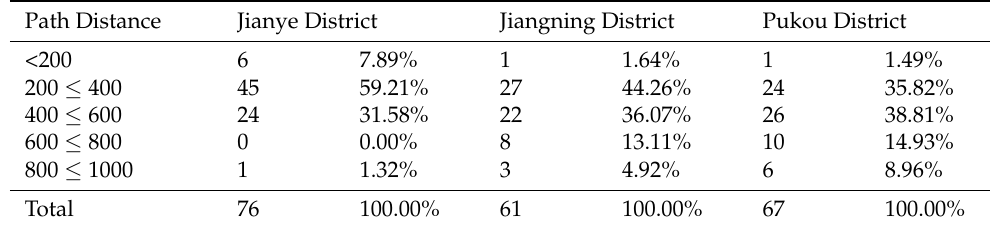
Table 7. Number and percentage of residential areas with different levels of path distance.